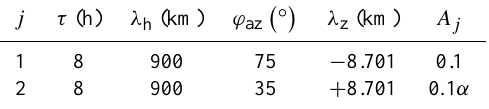
Table 1b. Same as Table 1a, but with different azimuth angles.